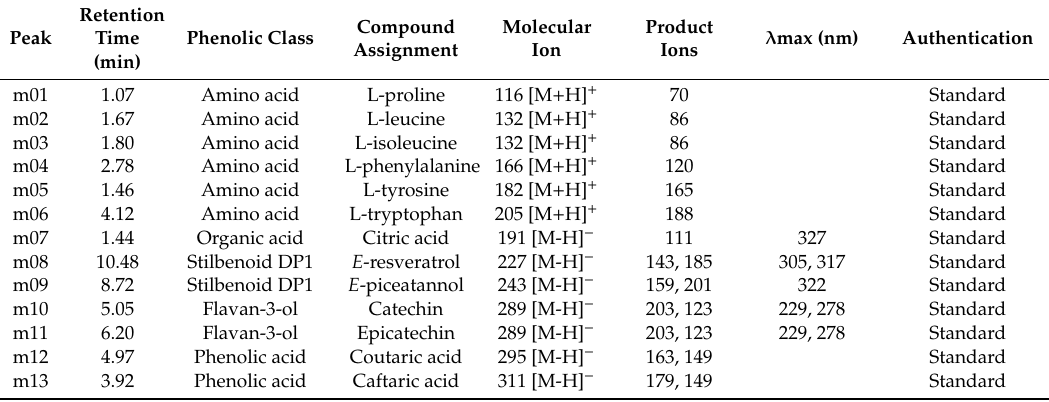
Table 1. List of polyphenols identified in grape leaves of Malbec